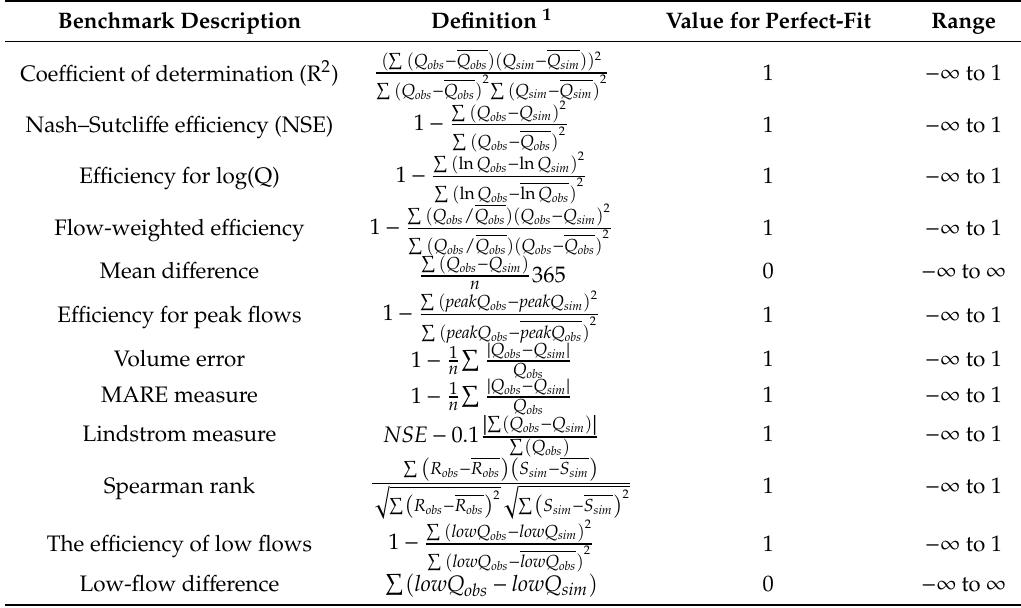
Table 3. Coe ffi cients for calibration quality assessments, goodness-of-fit measures according to [82]. Benchmark